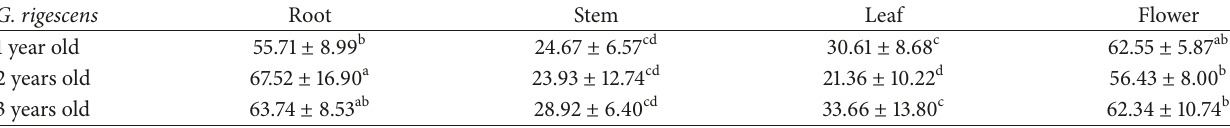
Table 2: The variation of total iridoid glycosides according to different parts and cultivation ages.